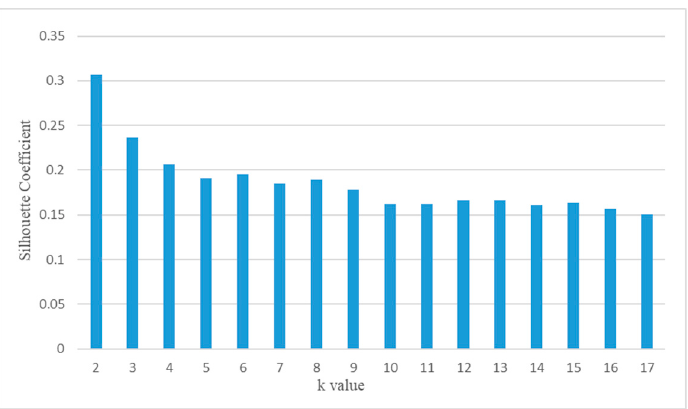
Figure 7. Silhouette score of K-Means clustering with different k values (k presents the number of clusters in cluster analysis). Figure 8 maps the K-Means clustering results with different values of k: